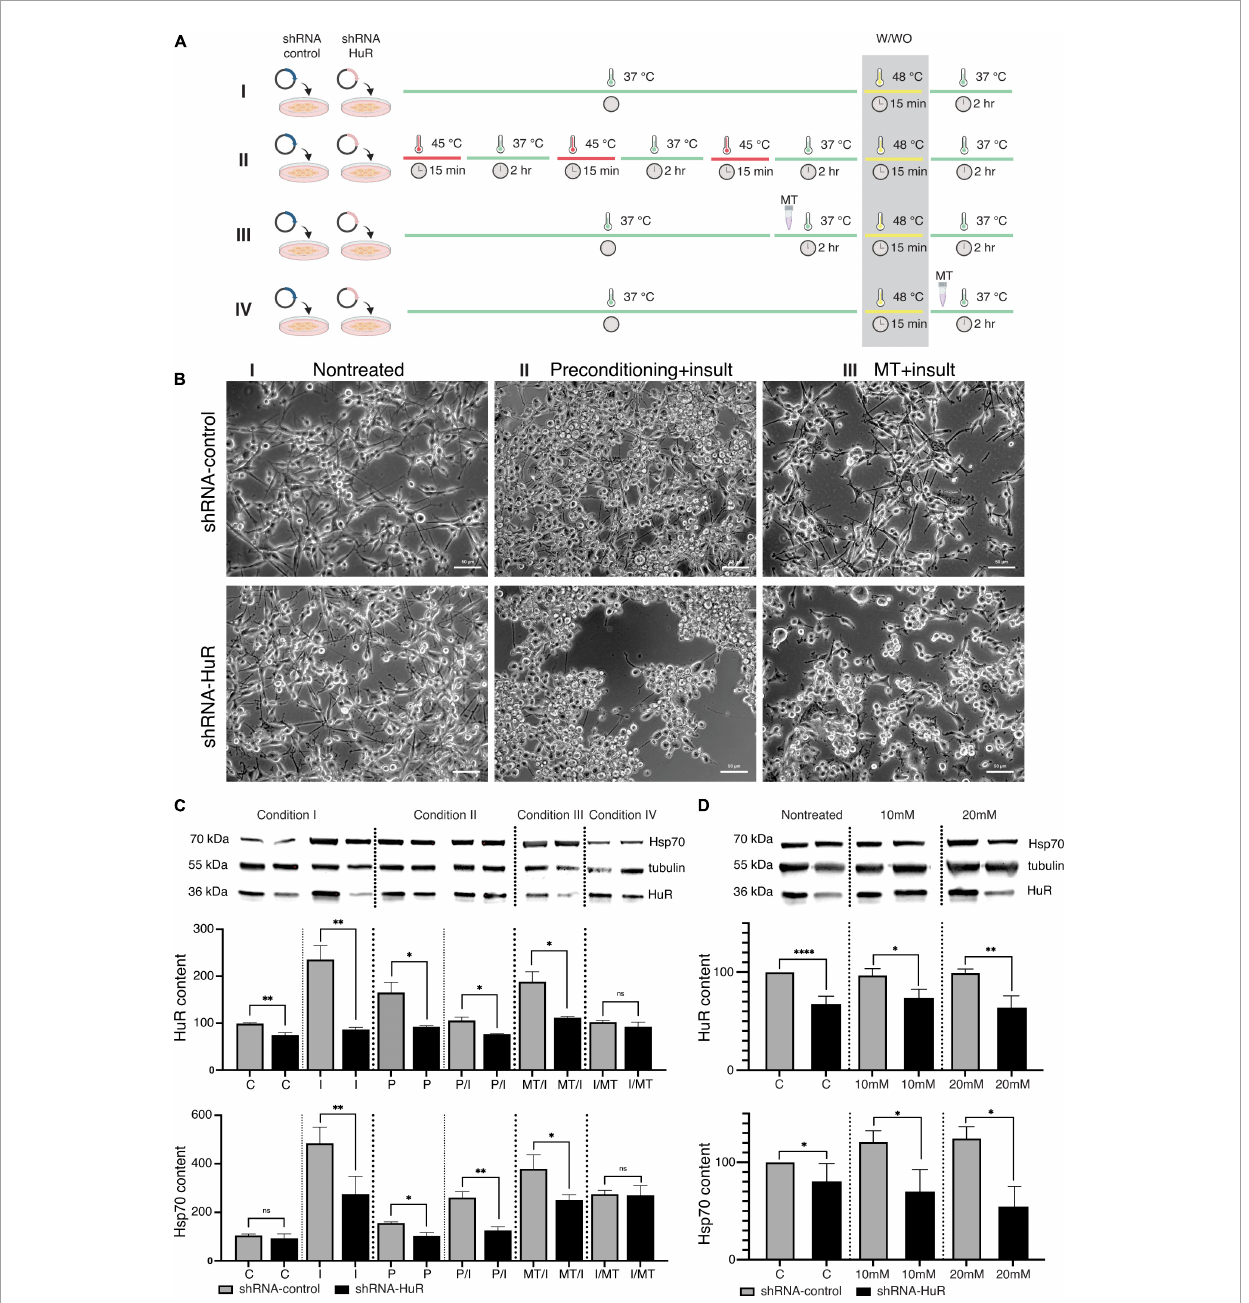
FIGURE2 In vitro validation experiment using two cell death models, temperature insult and NMDA excitotoxicity in B35 cells. (A) Scheme of the in vitro temperature insult experiment performed in B-35 cells. Condition I—cells underwent transfection with either shRNA-HuR or shRNA-control: “C”—control group was cultured in standard medium and standard temperature condition; “I”—insult group was cultured in standard medium and was exposed to 48 ◦ C for 15 min. Condition II—cells underwent transfection with either shRNA-HuR or shRNA-control, then cells were exposed to temperature preconditioning by applying 3 rounds of 15 min of incubation at 45 ◦ C every 2 h, then one group was cultured in standard medium and standard temperature condition (“P” group) and the other group was exposed to 48 ◦ C for 15 min insult (“P/I” group). Condition III—cells underwent transfection with either shRNA-HuR or shRNA-control, then cells were treated with 1 µ g/mL of MT for 2 h, following exposition to 48 ◦ C for 15 min insult (“T/I” group). Condition IV—cells underwent transfection with either shRNA-HuR or shRNA-control, then cells were exposed to 48 ◦ C for 15 min insult, following treatment with 1 µ g/mL of MT for 2 h (“I/T” group). Condition IV did not exert any visible preventive effects on cells, and it was used solely as a reference group for WB analysis. (B) Light microscopy images of cultured B-35 cells exposed to the two preventive approaches, either temperature preconditioning or MT treatment, followed by high-temperature insult. Condition IV (not shown in photographs) did not exert any visible effects on cells, and it was used solely as a reference group for WB analysis. Scale bar = 50 µ m. (C) Western blot analysis (two biological replicates for each group) and representative images of cytoplasmic HuR and Hsp70 protein levels; shRNA-control- and shRNA-HuR-treated B-35 cells were exposed to either preconditioning or MT before or after the insult (heat shock), as described above. ∗∗ p < 0.01, ∗ p < 0.03, and ns, not significant. (D) shRNA-control- and shRNA-HuR-treated B-35 cells were exposed to two different concentrations of NMDA, 10 or 20 mM for 24 h, in order to investigate the impact of excitotoxic insult on the cells with HuR deprivation; “C”—cells transfected with shRNA-control or shRNA-HuR with no insult applied; “10 mM,” “20 mM”—cells treated with either constructs + 10- or 20-mM NMDA. ∗∗∗∗ p < 0.001, ∗∗ p < 0.01, and ∗ p <